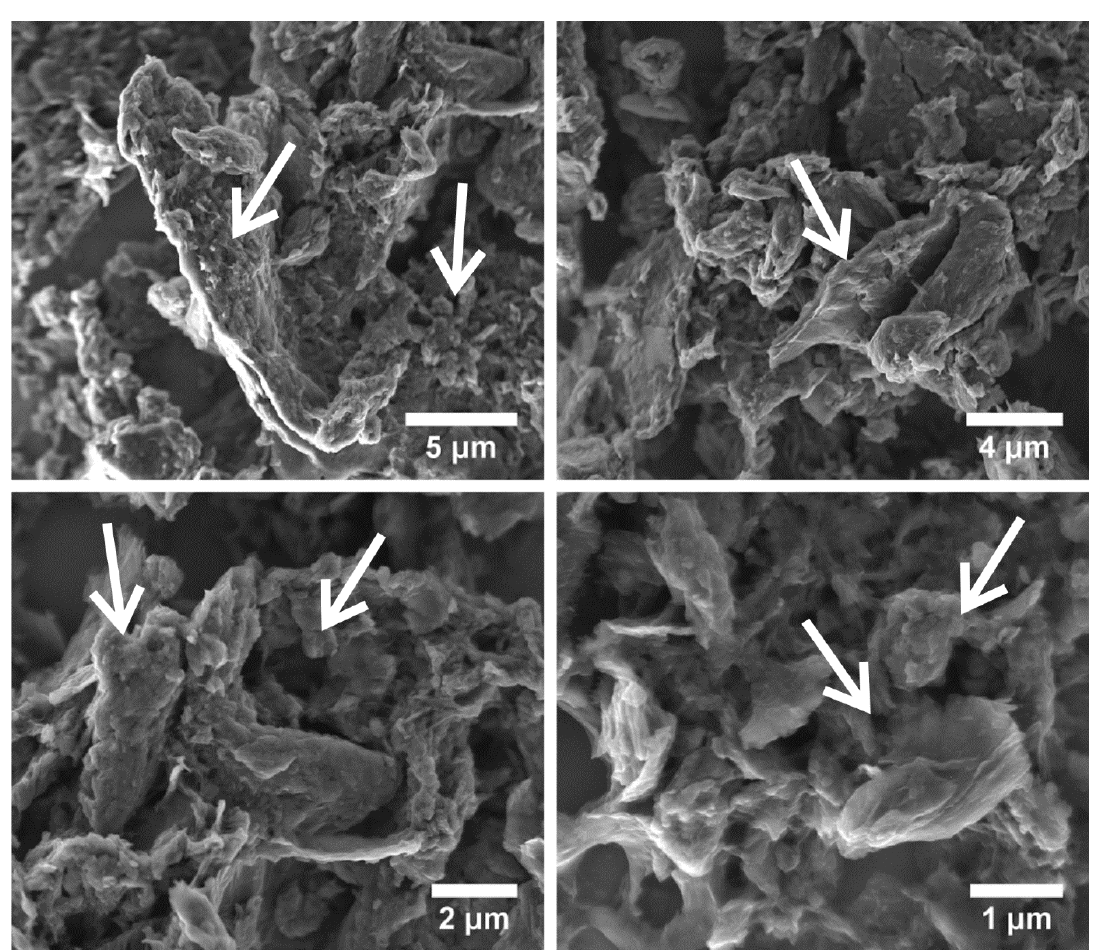
Figure 3. SEM images of graphene oxide material. The arrows showed particularity of obtained graphene oxide.